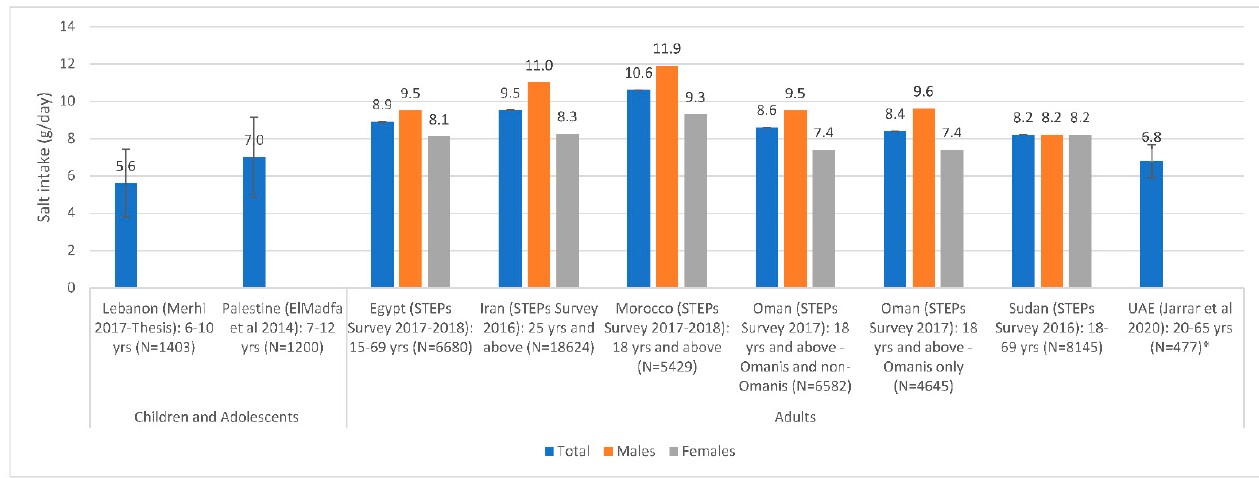
Figure 2. Salt intake estimates based on national urinary excretion studies in countries of the EMR#. Abbreviations: EMR: Eastern Mediterranean Region; UAE: United Arab Emirates. References: For Children and Adolescents: Lebanon: Merhi 2017–Thesis [63]; Palestine: ElMadfa et al., 2014 [81]. For Adults: Egypt: STEPs Survey 2017–2018 [29]; Iran: STEPs Survey 2016 [33,36]; Morocco: STEPs Survey 2017–2018 [89]; Oman: STEPs Survey 2017 [76,90]; Sudan: STEPs Survey 2016 [82]; UAE: Jarrar et al., 2020 [87]. *: All studies were based on spot urine assessment with the exception of UAE (Jarrar et al., 2020), which was based on a 24 h urinary assessment. #: Error bars (standard deviations around the mean) are presented, when available.